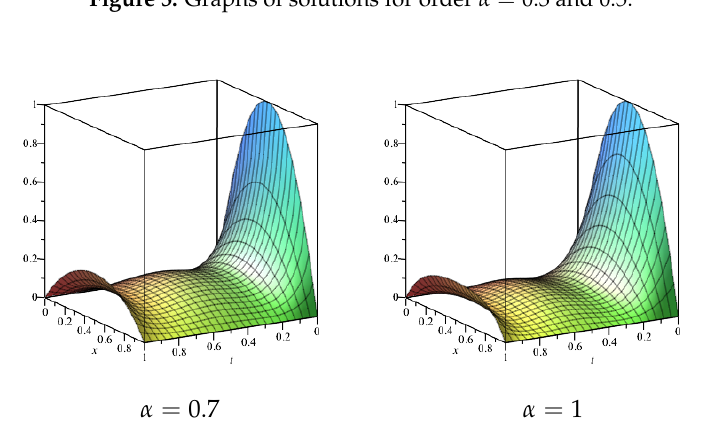
Figure 6. Graphs of solutions for order α = 0.7 and